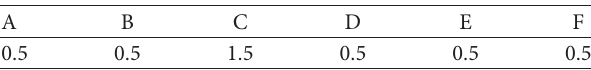
Table 5: Initial preset cracks of three-hole specimen with variable amplitude.